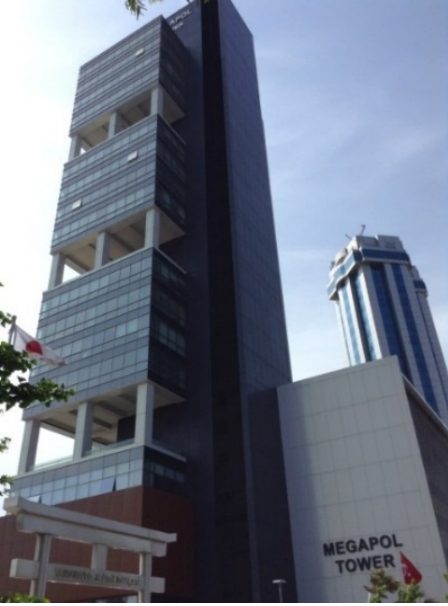
Figure 9. External View of Megapol Tower. Photograph by Burkay